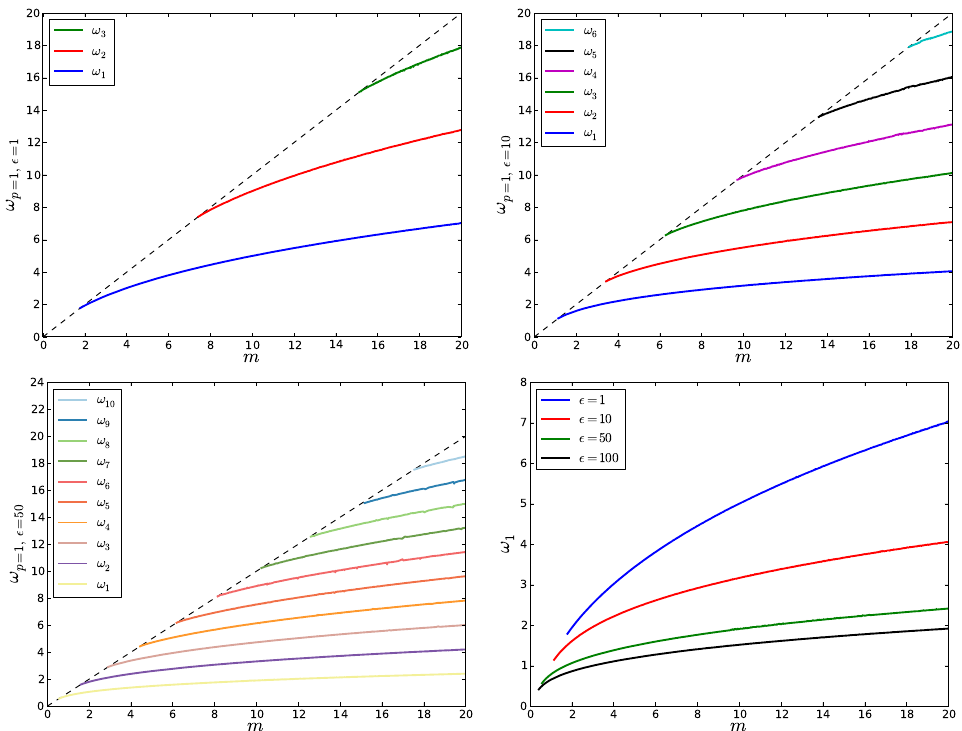
Figure 13 . The lowest oscillating modes for the L 2460 Skyrme model with the usual Skyrme ( p =1) for (cid:15) = 1 ; 10 ; 50, as a function of the pion mass m . In the last panel, we show the potential U (cid:12)rst oscillating mode ! 1 for di(cid:11)erent (cid:15) .